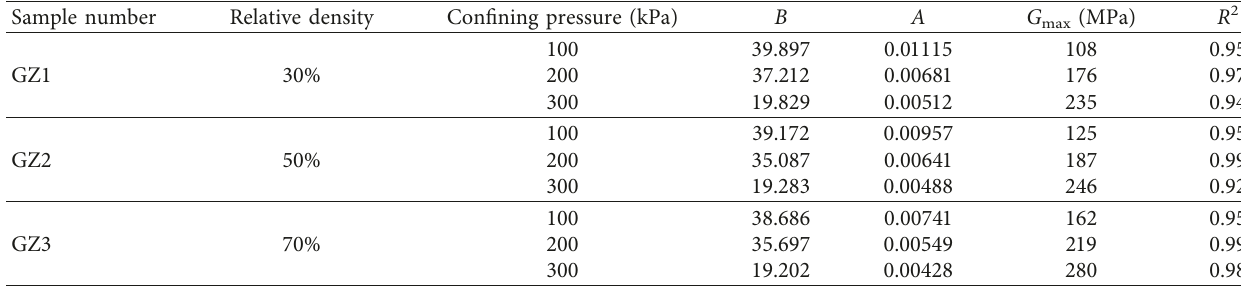
Table 3: Fitting parameters of G − 1